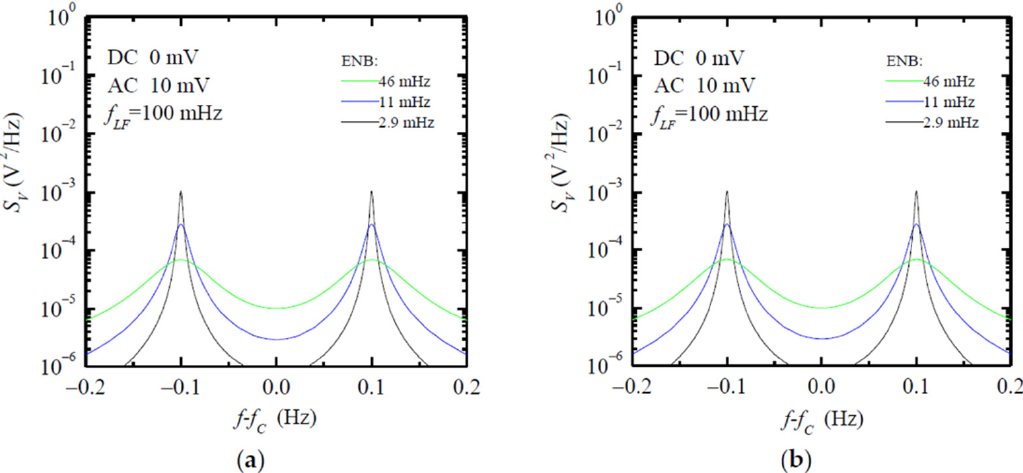
Figure 4. Spectra estimated by QLSA in NB mode when synthetic data are used for creating the signal V OL in Equation (2) with different settings for ENB. In ( a ) the DC level of the test signal across the DUT is set to 0, while in ( b ) we set a DC level of 100 mV across the DUT.